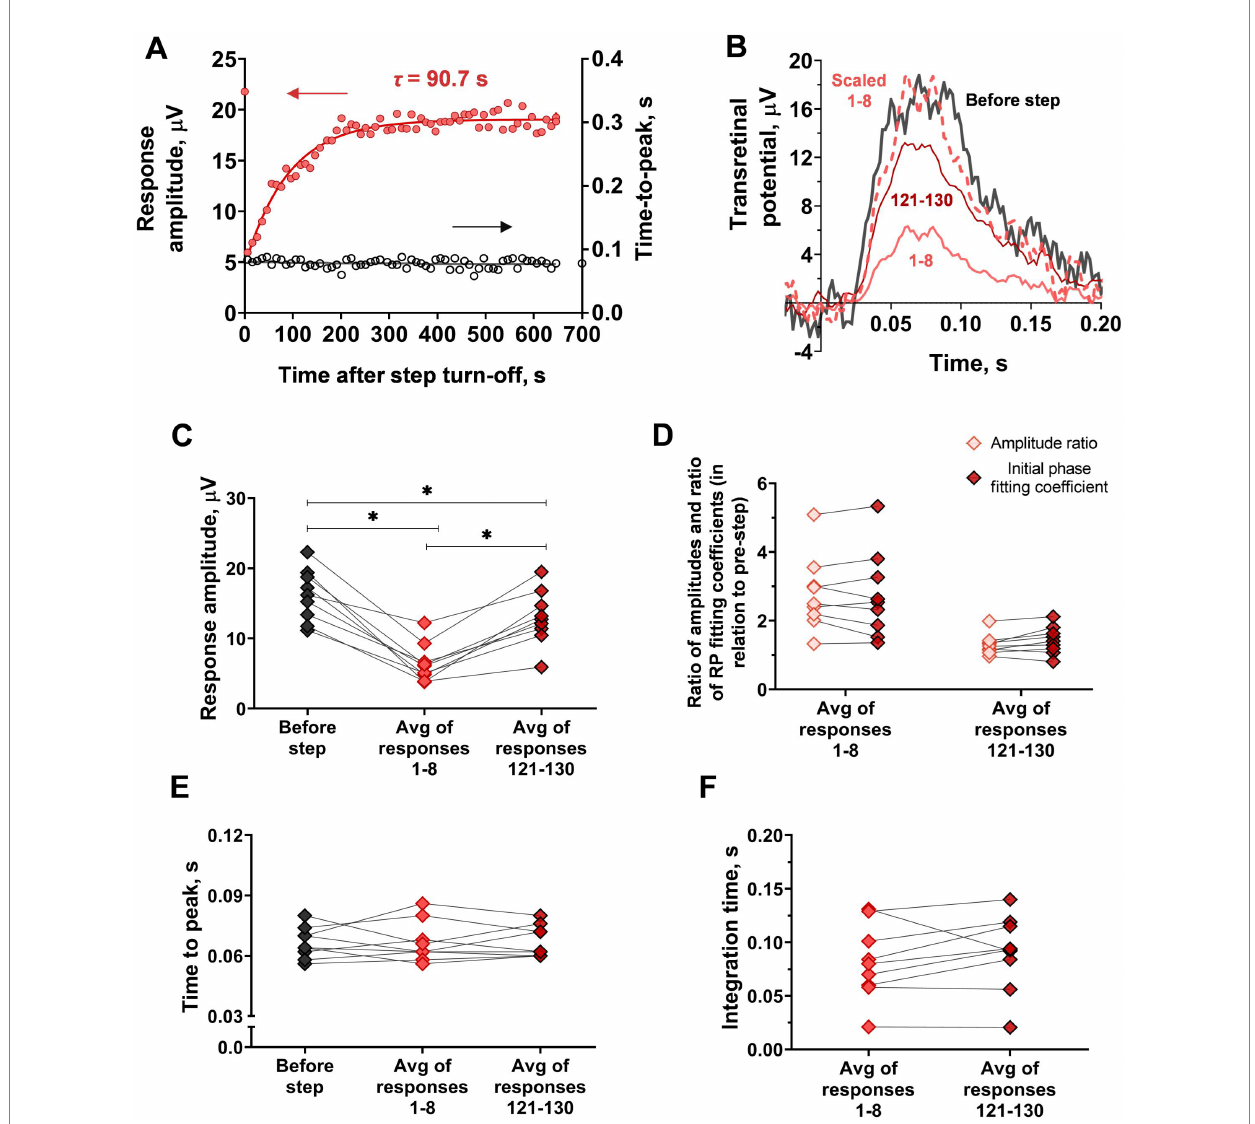
FIGURE 8 Analysis of response kinetics in relation to ‘adaptation memory’ in red-sensitive frog cones recorded by ex vivo ERG. (A) Comparison of the sensitivity recovery rate (red circles, left Y-scale) and time-to-peak recovery rate (black circles, right Y-axis). For reference, the point plotted at time zero illustrates the pre-step value. (B) Superimposing of selected responses to the same brief test flashes recorded at different time points after step turning-off cut from the recordings presented in Figure 7A. The bold black curve corresponds to pre-step photoresponse; light red curves are the averaged 1st to 8th photoresponses and the dark red curve is the averaged 121st to 130th photoresponses recorded after step turning-off. The dashed curve represents the averaged 1st to 8th response, scaled to coincide with the amplitude of the pre-step. (C) – F) comparison of several response parameters: response amplitude (C) , the ratio of response amplitude and the fitting coefficient for the rising phase (RP fitting coefficient) (D) , time-to-peak (E) and integration time (F) , for pre-step responses, averaged early response after the step turn-off (‘Response 1–8’) and averaged last observable response after step turn- off (‘Response 121–130’). Asterisk * indicates statistically significant differences between groups (Holm-Sidak test; p < 0.05). Sample sizes n =